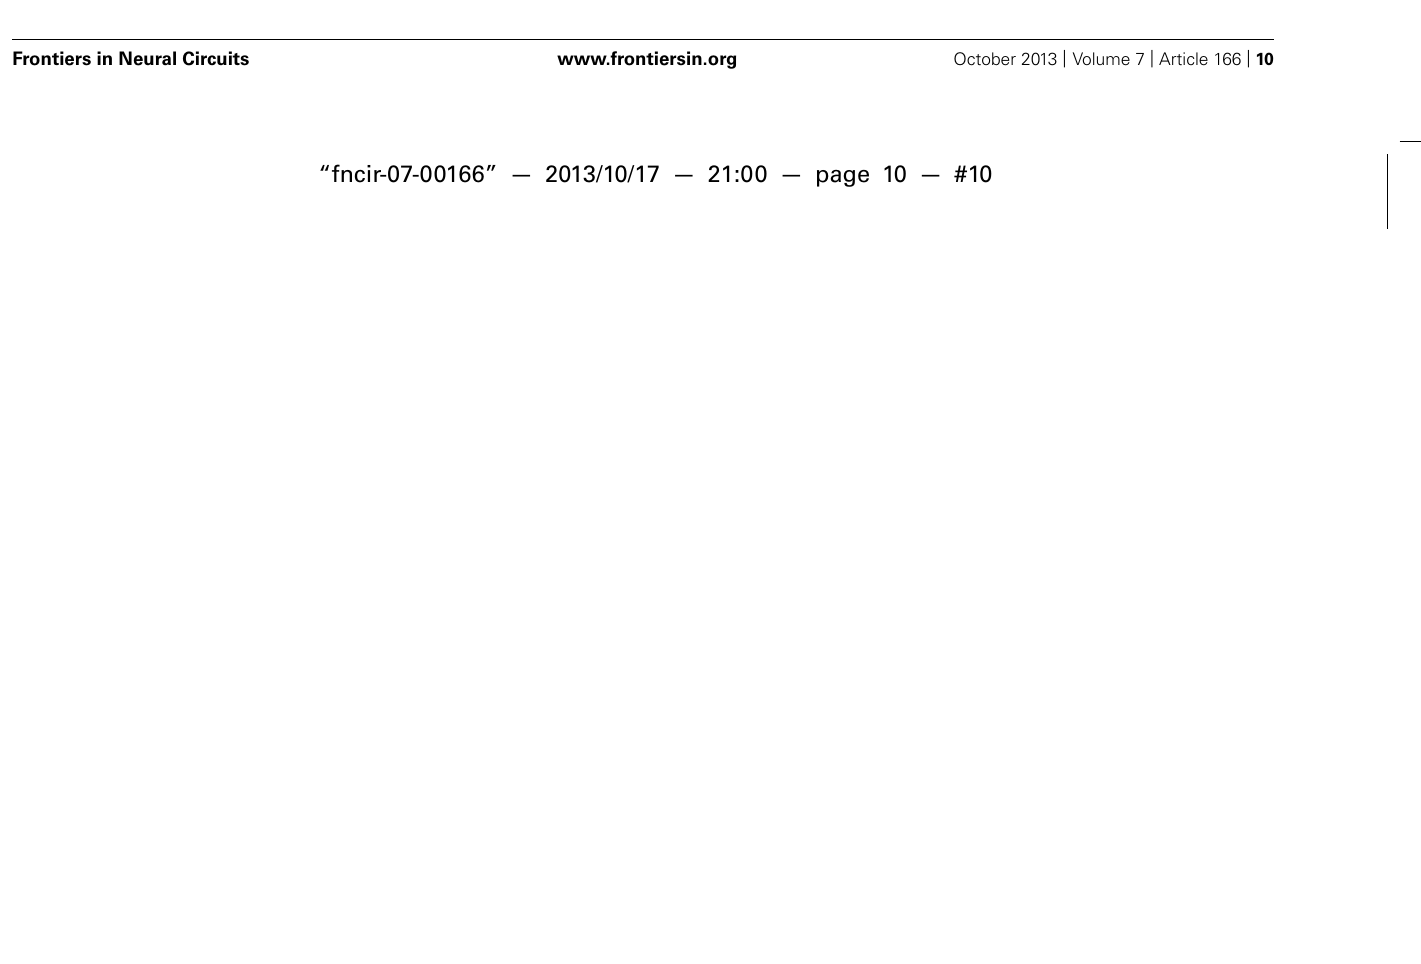
transform. (C) Spectrogram made from the frequency-specific envelopes outputted from the DRNL model. Each row of the plot is an envelope outputted from one discrete DRNL frequency channel. Note that the different frequency channels of the DRNL model overlap in frequency ranges and thus smear the spectrogram plot in the frequency dimension. (D) Neural representation of the spectrotemporal features of activity recorded across all 239 sites. Each row is a PSTH recorded from each ICC site for a specific best frequency region. dB FS decibels relative to full scale in which 0 dB FS corresponds to the maximum